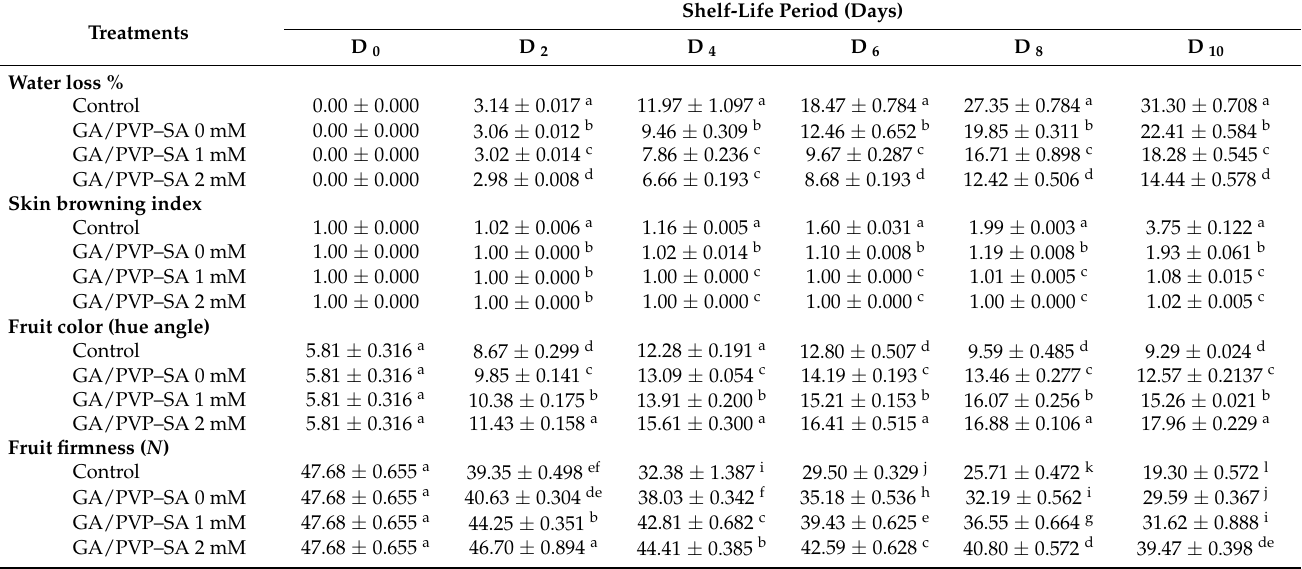
Table 1. Effect of different treatments of gum arabic (GA) and polyvinylpyrrolidone (PVP) blending with salicylic acid (SA) at different concentrations as a mixture biopolymer coating treatment (GA/PVP–SA) on physical properties of peach fruit ‘Early Sweet’ during shelf life at ambient air (29 ± 1 °C and air humidity 51%) during two seasons (2020 and 2021).